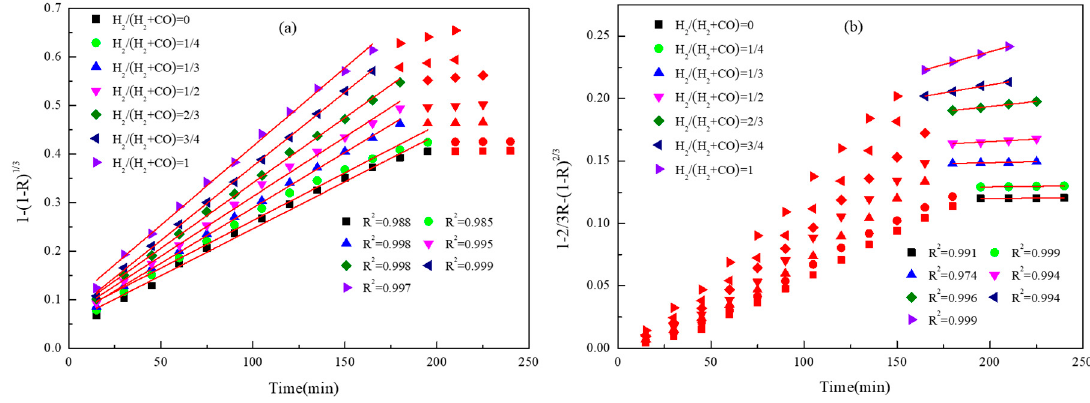
Figure 9. The reduction degree curves of oxidized VTM pellets at 1273 K with H 2 /(H 2 + CO) ratios. ( a ) the plot of 1 − ( 1 − R ) 3 vs. time and ( b ) plot of 1 − 2 3 R − ( 1 − R )